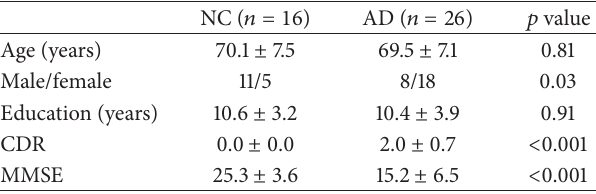
Table 1: The demography and clinical scores of the subjects in the study. The 𝑝 values are based on the two-sample 𝑡 -tests except the gender. The gender ratio was examined by the Chi-squared